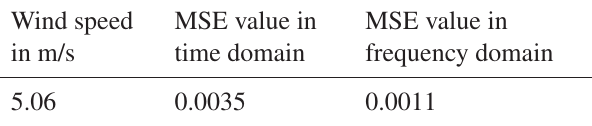
Table 2. Comparison of MSE values in time and frequency